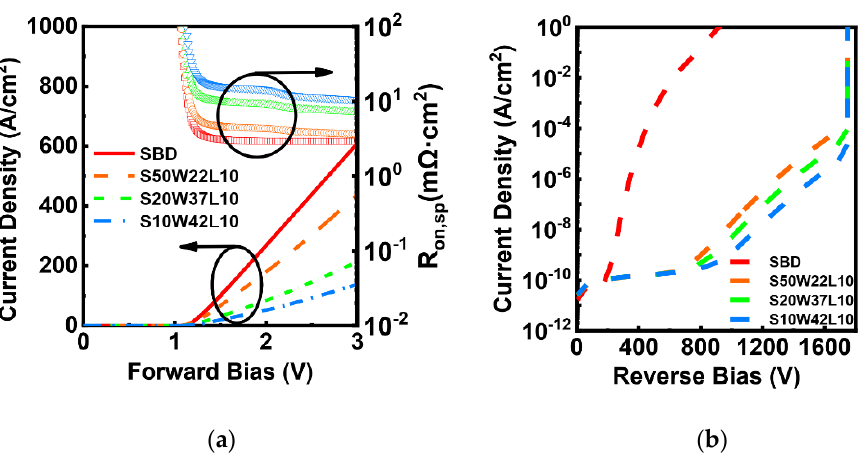
Figure 5. ( a ) Forward J-V characteristics and R on,sp vs. forward bias and ( b ) reverse J-V characteristics of the Ga 2 O 3 SBD with different width (W), spacing (S) of GRs and the one with no GR, at a p-NiO doping concentration of 1 × 18 cm − 3 and a drift layer thickness (L) of 10 μ m.